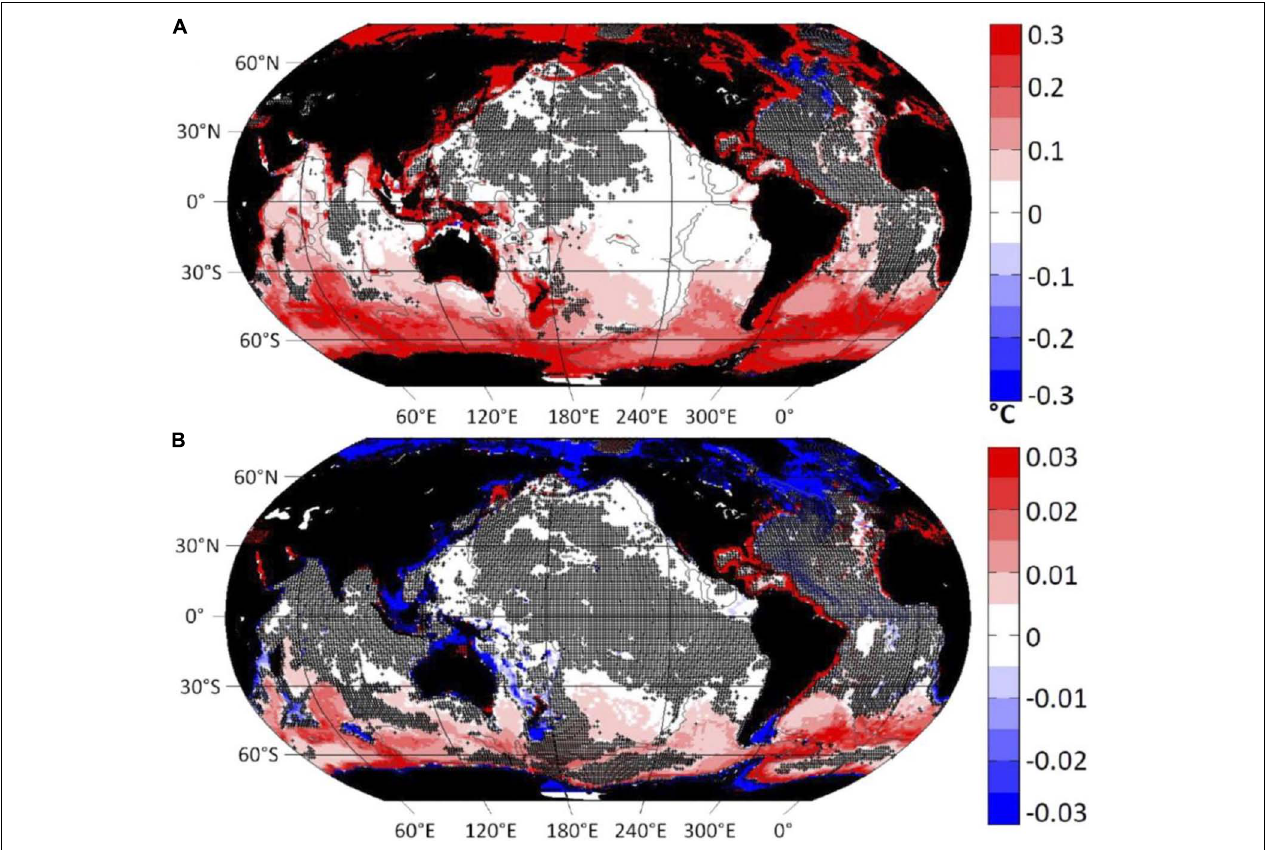
FIGURE 4 | RCP8.5 multimodel mean change (2081–2100 minus 1986–2005) in (A) bottom temperature, and (B) bottom salinity. Control drift has been removed. Black stippling indicates areas where fewer than 16 models agree on the sign of the change. Gray contour indicates the 3000-m isobath. Figure adapted from Heuzé et al. (2015).©American Meteorological Society. Used with